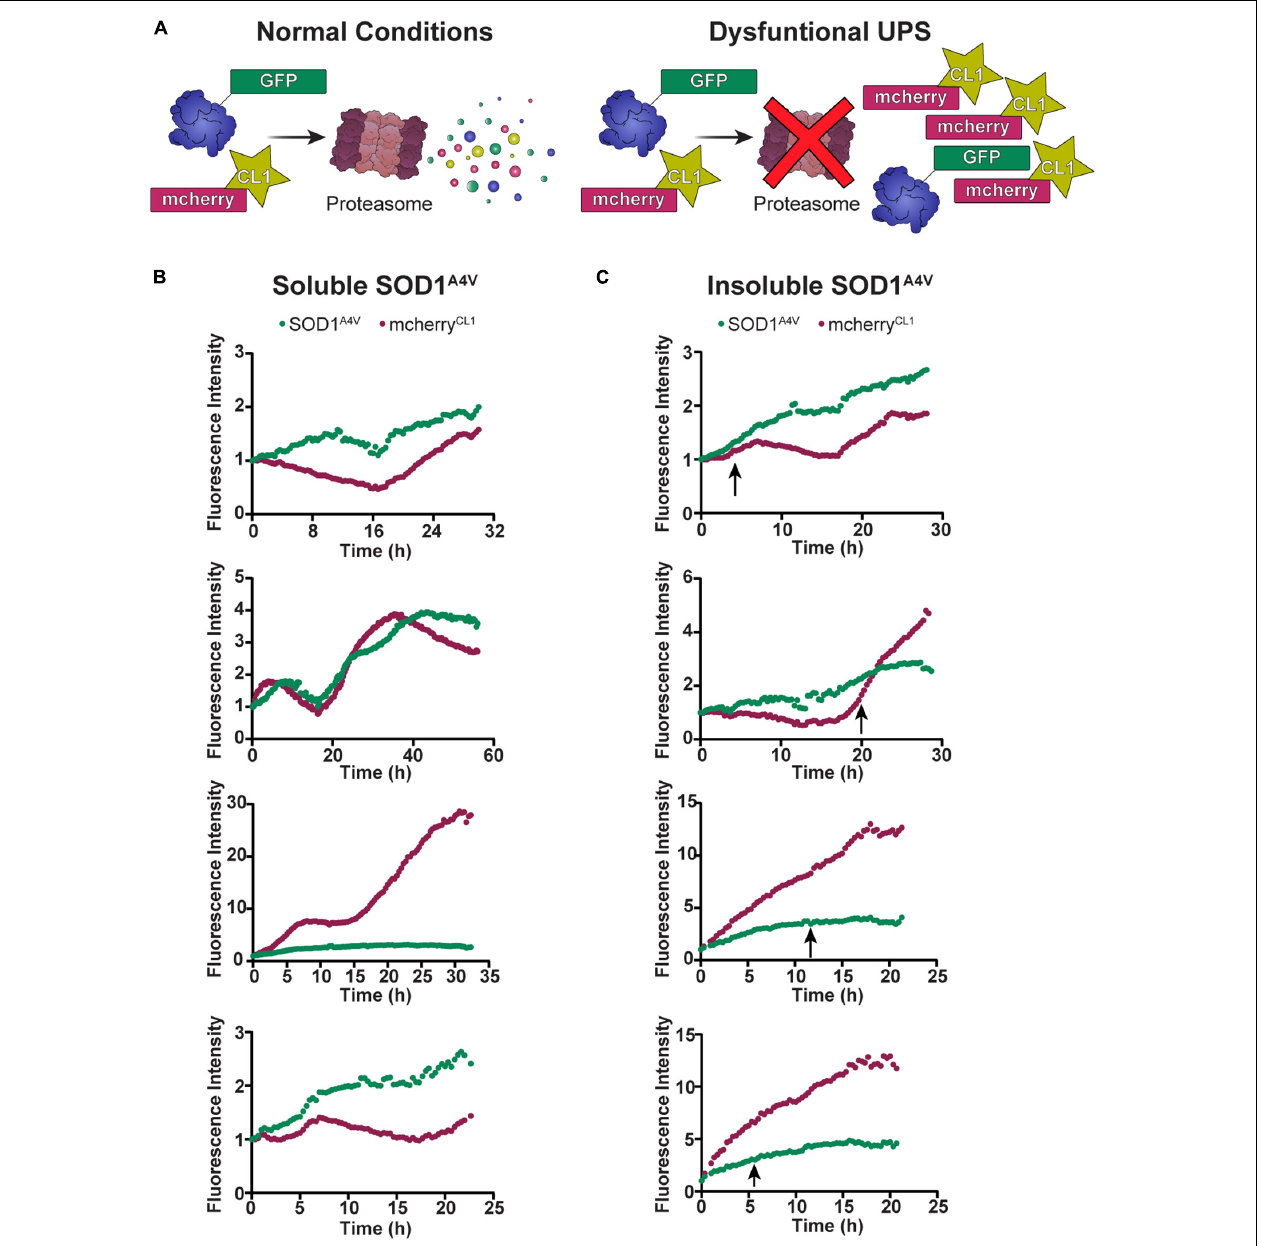
FIGURE 3 | The UPS slows prior to SOD1 A4V aggregation. (A) Under normal conditions, mcherry CL1 is rapidly degraded by the proteasome, but if the UPS is overwhelmed or impaired, we see an accumulation of mcherry CL1 which can be measured by an increase in fluorescence intensity. The fluorescence intensity of SOD1 A4V -GFP and mcherry CL1 was followed in NSC-34 cells expressing (B) soluble SOD1 A4V -GFP and (C) insoluble SOD1 A4V -GFP. Data represent individual cell traces with arrows indicating the time point at which insoluble SOD1 A4V –GFP aggregates first